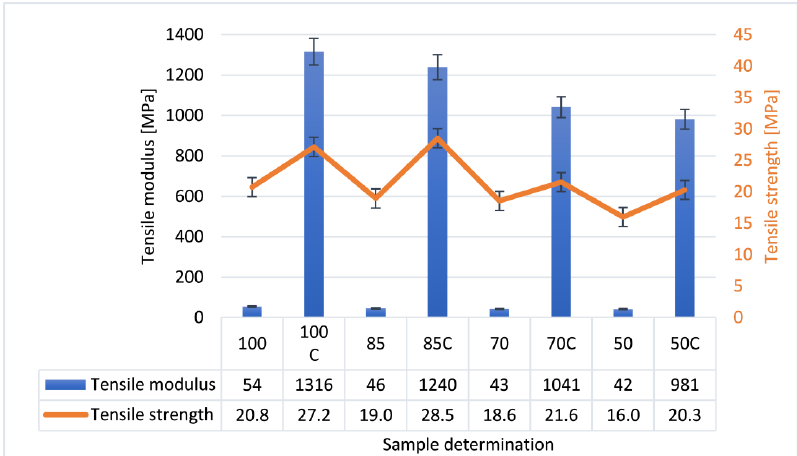
Figure 2. Comparison of mechanical properties examined during static tensile test for untreated and crystallized samples measured at 70 °C.